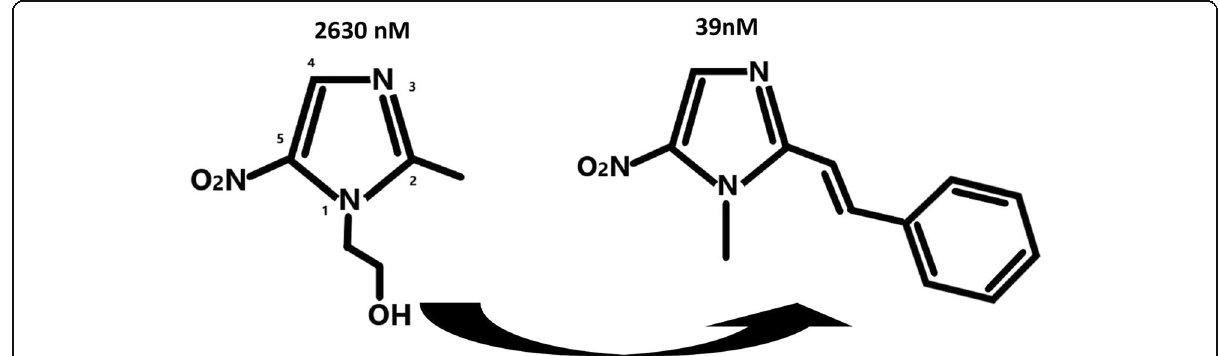
Fig. 9 Example of structural diversity in potency — metronidazole and its potent